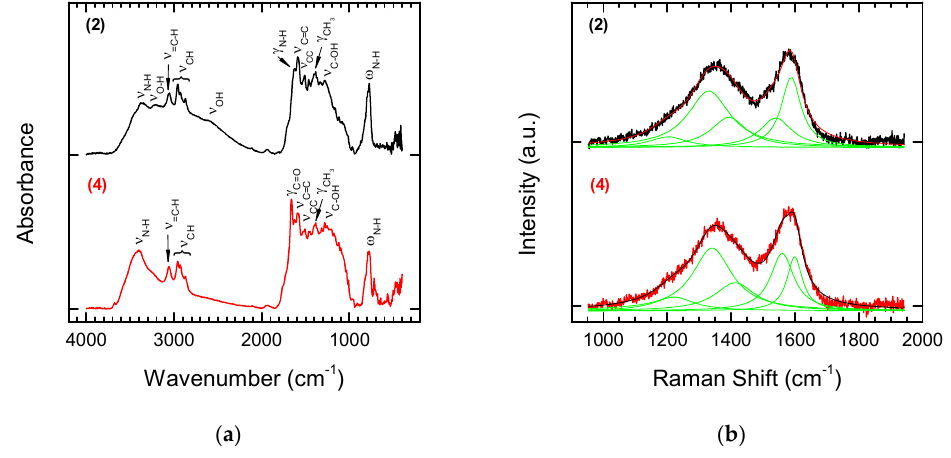
Figure 7. FT-IR ( a ) and Raman spectra ( b ) of NDP 2 (upper panel) modified with Ketoprofen (lower panel).